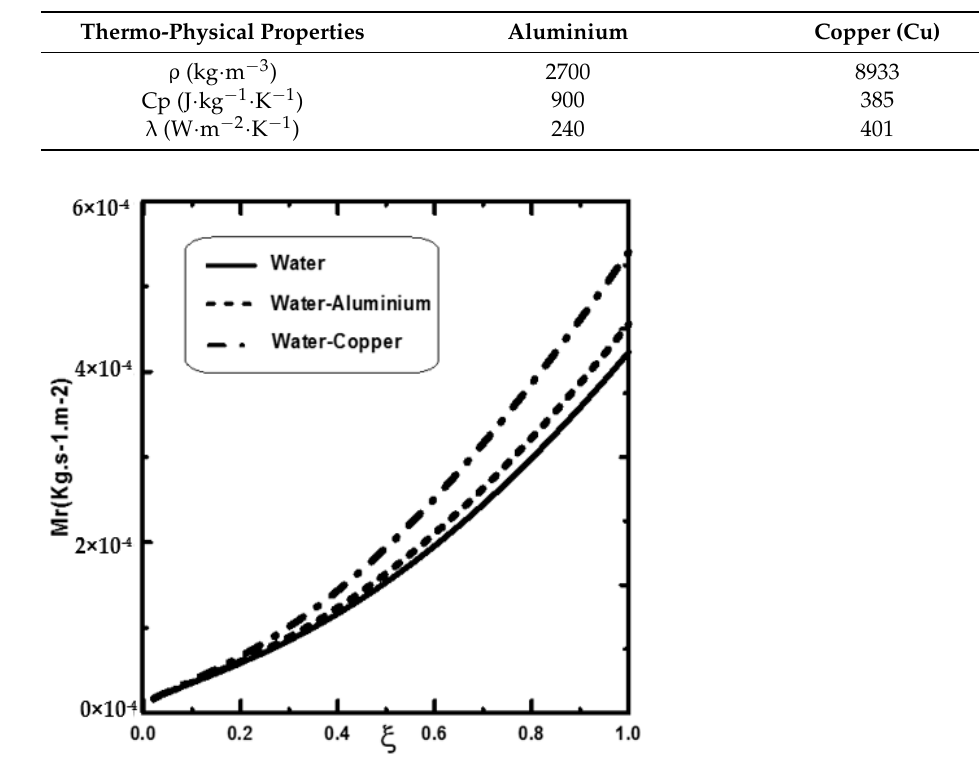
Figure 5. Effect of nanoparticles type on the cumulated evaporation rate: T 0 = 20 °C, T 0L = 20 °C, q 1 = 3000 W/m 2 , T w = 20 °C, c 0 = 0, u 0 = 1 m/s, m 0L = 15 × 10 − 4 Kg/m.s, p 0 = 1 atm, d/H = 0.015, φ 0 = 0.05.